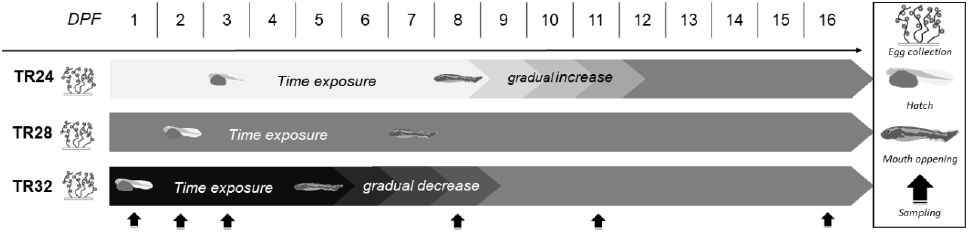
Figure 1. Experimental design to determine the effect of temperature during the early development of tropical gar ( Atractosteus tropicus ) (16 dpf). The exposure period is shown for each treatment, as well as the temperature transition and when the samplings were performed. Fifteen larvae were randomly collected at hatching, 8, 11 and 16 dpf from each treat- ment for standard length (SL) and wet body weight (WBW) individual assessment. For skeletal development and body morphology analysis, 10 larvae were collected from each sampling time, 40 per thermal group. For both analytical purposes, fish were first eu- thanized with an overdose of MS-222. After, larvae for skeletal development were fixed in 4% paraformaldehyde (PFA) with 1× phosphate-buffered saline (PBS) at pH 7.4 for 24 h. Then, larvae were rinsed in 1× PBS for 15 min and progressively dehydrated in absolute ethanol-PBS solutions (25:75, 50:50 and 75:25 v / v ) and finally preserved in 100% absolute ethanol until processing. 2.4. Survival and Growth Survival was assessed by counting the number of dead larvae every day from every TR. Growth performance was evaluated as changes in WBW, SL and Fulton’s condition factor (K). WBW (in milligrams) of the larvae was accounted using an analytical balance; SL was measured using a digital caliper to the closest millimeter. Condition factor was calculated as K = (WBW ÷ SL 3 ) × 100 [34]. 2.5. Skeletal Development Assessment and Body Morphology Biometrics To analyze the degree of development of skeletal structures in the tropical gar, the acid-free double stain protocol described by [35] was previously adapted and conducted. Processed larvae were observed under a dissecting microscope SMZ 25 to analyze osteological development and high-resolution photographs were taken. The degree of skeletal development was evaluated as the proportions of ‘red pixels’ (for bone) or ‘blue pixels’ (for cartilage) of the total surface of the fish (in pixels). Photographs and measure- ments were analyzed in the software Image J (Version 1.50i, https://im- agej.nih.gov/ij/download.html (accessed on 1 December)). To explore how the exposure to different TRs determined the body morphology, dif- ferent biometric measures (including pre-orbital length, body depth at cleithrum, pre-pec- toral length, pre-pelvic length, pre-anal length, head length and width, jaw length and width, distance between ceratohyals at ossification front and length of ossified ceratohyal) were assessed. Since fish metabolism is temperature dependent, as well as skeletal development is growth dependent, biometric data was normalized with SL and °C day − 1 . Data normali- zation procedure consisted in dividing the corresponding values by the respective SL of the specimen and the °C day − 1 at each sampling point. Data on bone skeletal development degree (ratios) was normalized by the °C day − 1 at each sampling point. This procedure allowed us to reduce and/or avoid the potential effect of sampling individuals at different stages (temperature dependent) and effect of interindividual variability within each ex- perimental group [36].